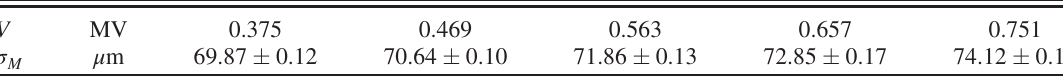
TABLE III. The beam sizes measured during the TDS scan, D ¼ 1 . 181